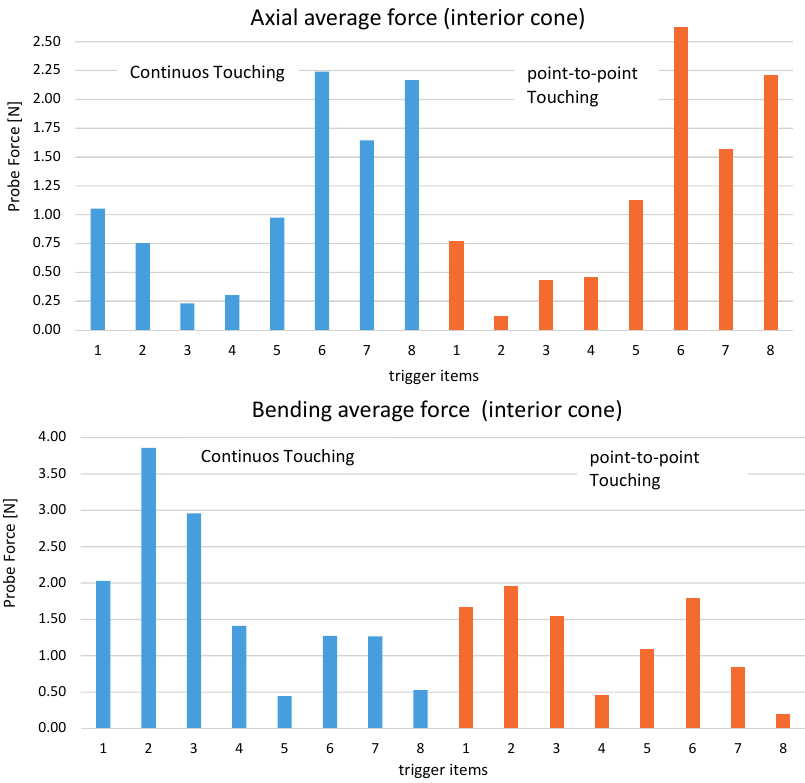
Figure 12. Average values of force for cones. ( Top ) axial; ( Bottom )